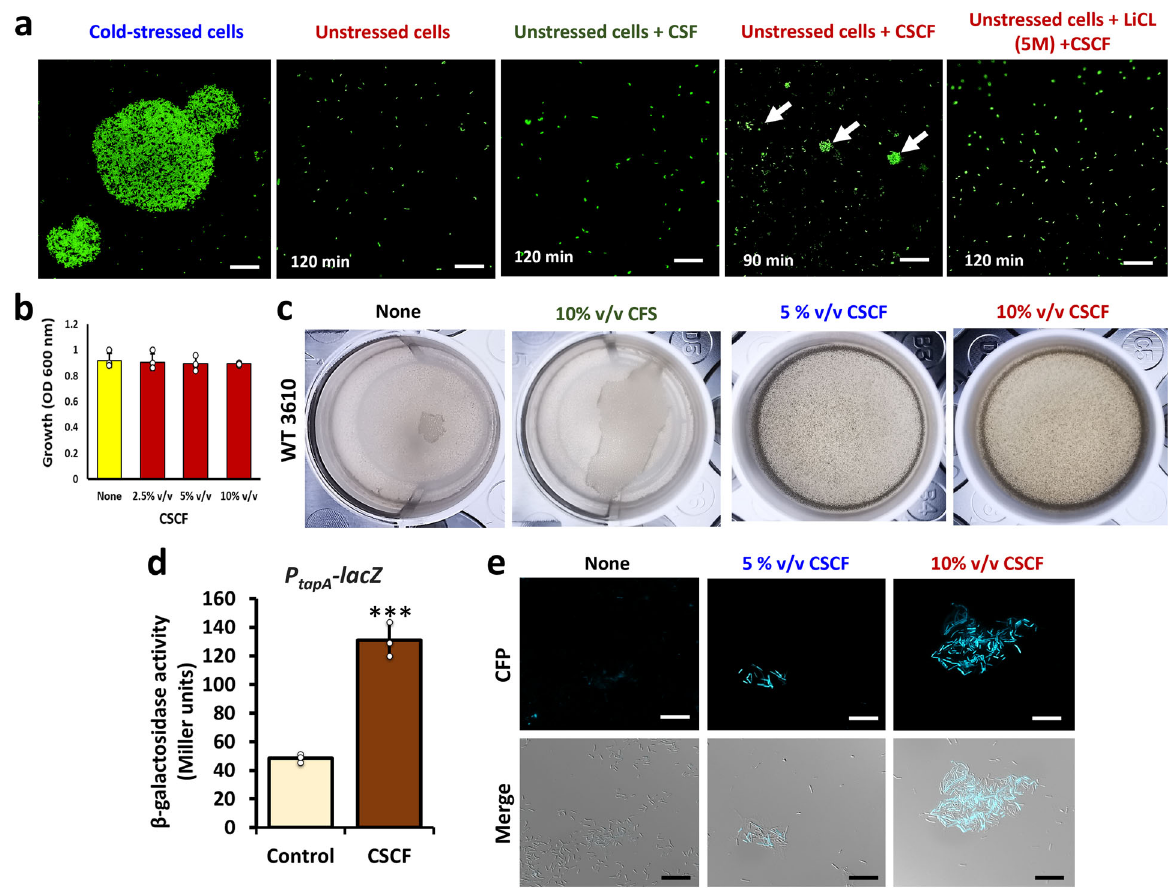
Fig. 4 Effect of CSCF from L. plantarum conic colonies on multicellular behaviour by probiotic Bacilli . a Effect of cold-shock colony fi ltrates (CSCF) on unstressed L. plantarum 3297 cells from conic colonies. Lithium chloride (5 M) is chemical that prevent cellular aggregation. Scale bar: 20 µm. White arrows indicate small bundles. b Effect of CSCF (10% v/v) on the growth of B. subtilis NCIB 3610 incubated at 37 °C for 24 h at 150 rpm. The graph shows the means ± SEMs of three measurements. * P > 0.05 vs. the control. c Effect of CSCF (10 % v/v) on pellicle formation of B. subtilis NCIB 3610 incubated at 30 °C for 48 h without shaking. d The β -galactosidase activity assay (measured in Miller units) in B. subtilis (YC121) cells harboring P tapA -lacZ transcriptional reporter. The graph shows the means ± SEMs of three measurements. ** P < 0.01, *** P < 0.001 vs. the non-treated controls. e Effect of CSCF (10% v/v) on bundle formation in B. subtilis (YC189), harboring a transcriptional reporter ( P tapA -cfp ) indicating on the matrix gene expressionf. Scale bar: 20